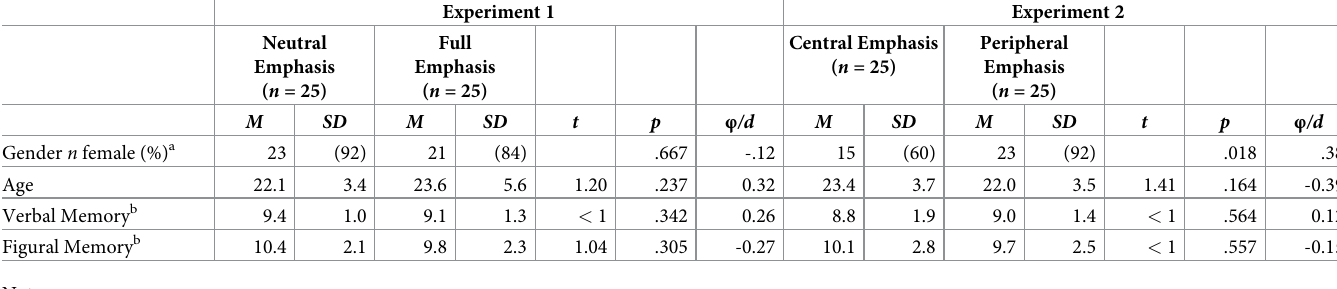
Table 1. Overview of sample descriptives and mean differences as a function of experimental